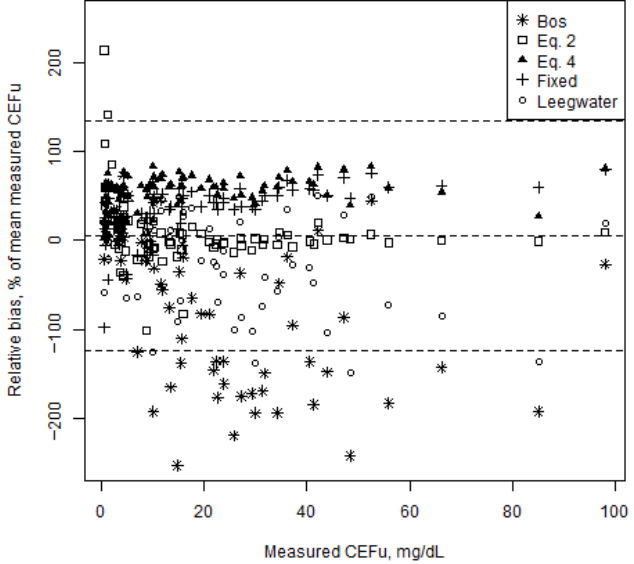
Figure 2. Bland–Altman plot representing the relative bias of the unbound ceftriaxone concentrations (CEFu) predicted from the five protein binding models vs. measured CEFu for all CEFu ( n = 72). Relative biases are shown as percentage of the mean measured CEFu ( y -axis) in function of the measured CEFu. The dashed lines represent the mean relative bias and the upper and lower limits of agreement (95% confidence inter- vals). Table 2. Agreement between measured and predicted unbound concentration of ceftriaxone.